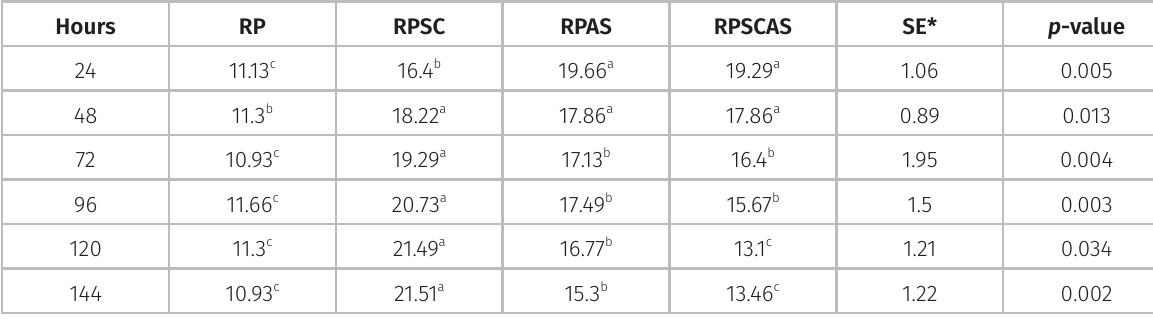
Means in the same row with different superscripts were significantly different from each other. *Standard error. RP, RPSC, RPAS and RPSCAS represent rice polishing, rice polishing plus Saccharomyces culture, rice polishing plus ammonium sulphate and rice polishing plus ammonium sulphate and Saccharomyces culture, Table II. Nutrient profile of rice polishing after fermentation. Nutrients (%) RP RPSC Ether extract